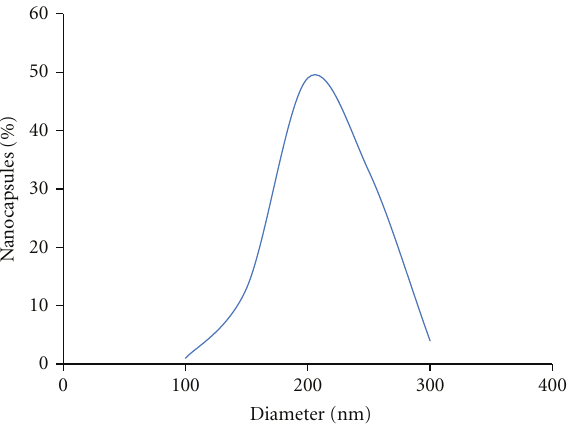
Figure 3: Size distribution of PLA nanocapsule [polyHb-Tyr].